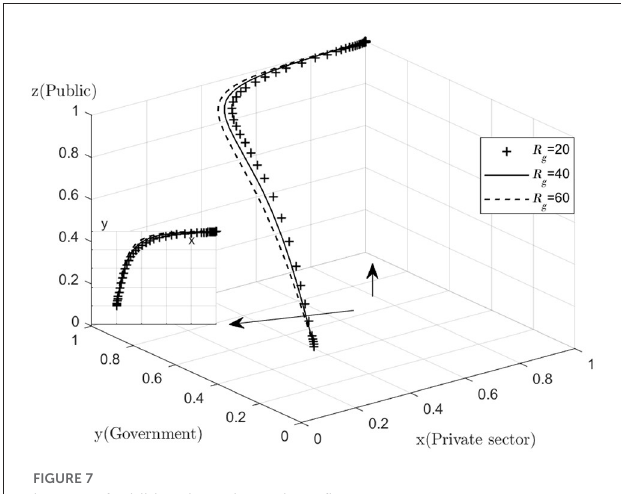
FIGURE5 Impact of government fines.